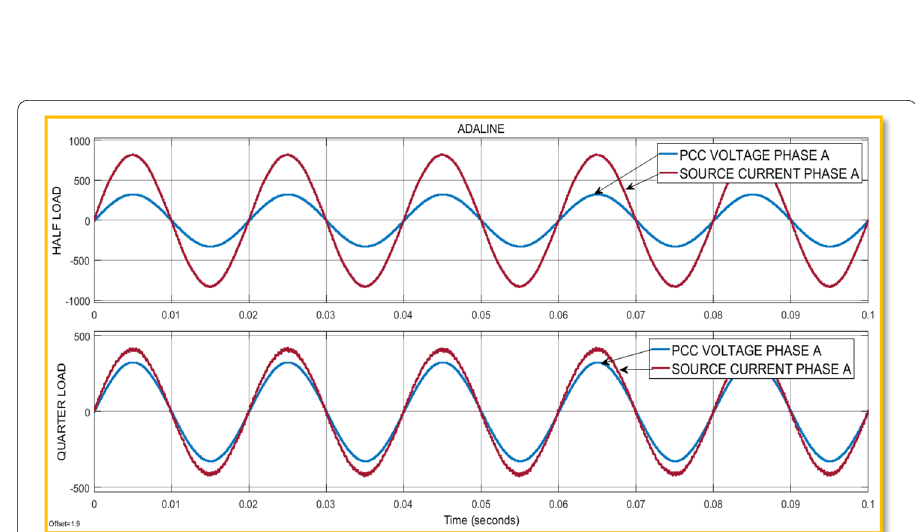
Fig. 21 Wave form of the voltage and current of phase a with ADALINE